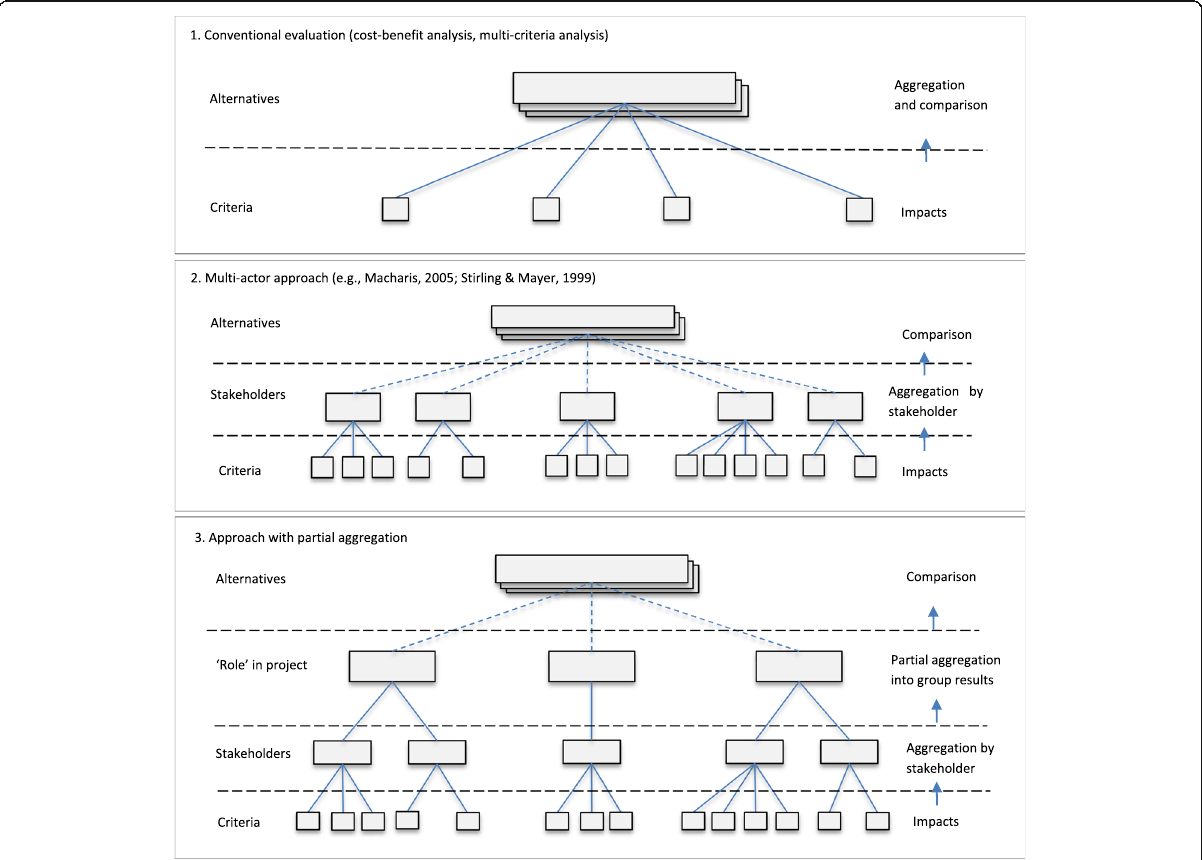
Fig. 5 The proposed approach with partial aggregation, in comparison to conventional evaluation and existing multi-actor approaches. Figure by